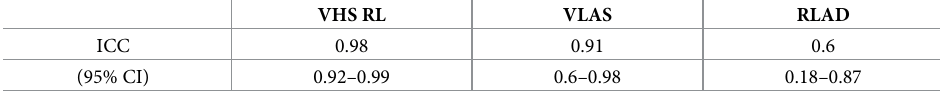
Abbreviations: CI, confidence interval; RLAD, radiographic left atrial dimension; VHS RL, vertebral heart score right lateral recumbency; VLAS, vertebral left atrial size.